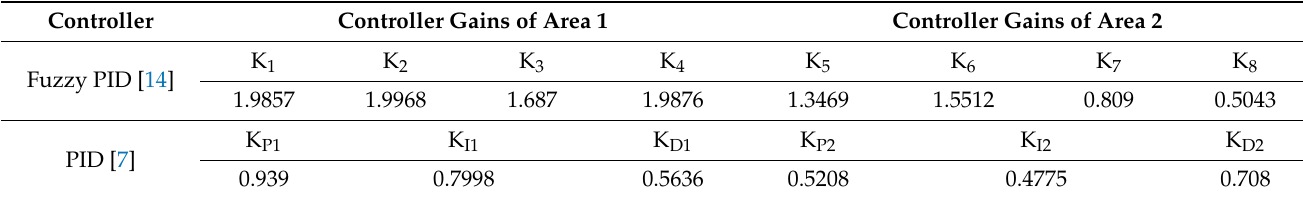
Table 4. The optimum gains of the controllers proposed in [7,14].